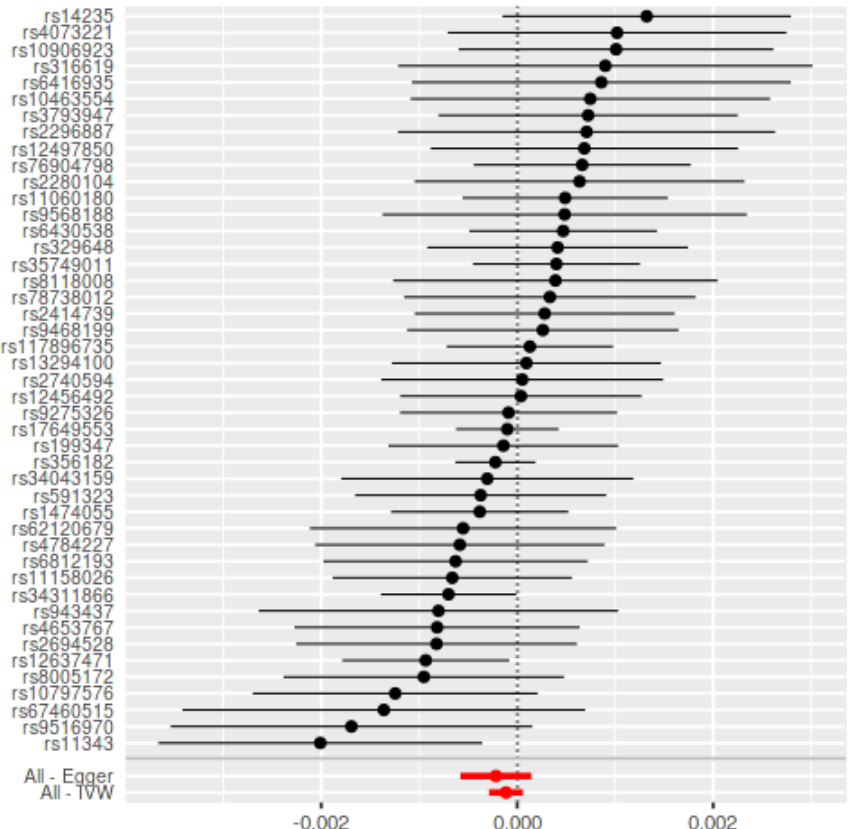
Figure 3. Mendelian Randomization summary effects for the risk of PD associated with periodontitis through random-effects approach for Chang et al. Summary effects were computed using inverse-variance weighted (IVW) method from each individual SNP. Dots represent the coefficient (B) and the extremities represent the 95% confidence interval of the odds ratio.